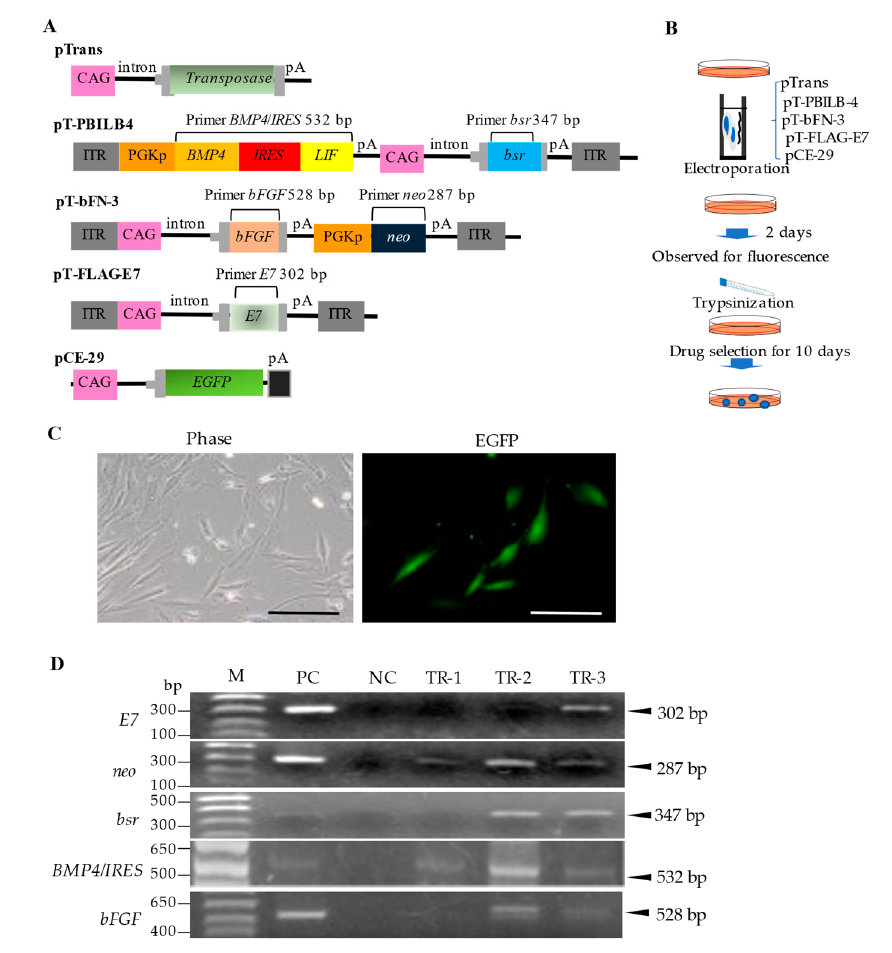
Figure 1. Isolation of GM HDDPCs via transfection using a PB transposon-based gene delivery system. ( A ) Plasmid construction. pTrans is a vector for the expression of PB transposase under the control of the CAG promoter. pT-bFN-3 is a PB -based vector that carries a bFGF expression unit under the control of the CAG promoter and a neo expression unit under the control of the mouse Pgk promoter. pT-PBILB-4 is a PB -based vector that carries a BMP4 / LIF expression unit under the control of the mouse Pgk promoter and a bsr expression unit under the control of the CAG promoter. pT-FLAG-E7 is a PB -based vector that carries a bovine papilloma virus-derived E7 expression unit under the control of the CAG promoter. pCE-29 is a plasmid vector for the expression of EGFP cDNA under the control of the CAG promoter. ( B ) Flowchart of the isolation procedure. ( C ) Fluorescence 2 d after transfection. Phase, photograph taken under light; EGFP, photograph taken under UV light. Scale bars, 50 µm. ( D ) PCR analysis of transfected clones (TR-1 – 3). Abbreviations: bFGF : basic fibroblast growth factor; BMP4 : bone morphogenetic protein-4; bsr : blasticidin S-resistance gene; CAG: chicken β -actin promoter; EGFP : enhanced green fluorescent protein; GM: genetically modified; HDDPC: human deciduous dental pulp cells; IRES : internal ribosomal entry site; ITR: inverted terminal repeat; LIF : leukemia inhibitory factor; M: molecular size markers; NC: negative control (genomic DNA from non-transfected HDDPCs); pA: poly (A) addition site; PB : piggyBac ; PC: positive control (5 ng of each plasmid); Pgk: phosphoglycerate kinase; Pgkp: Pgk promoter.